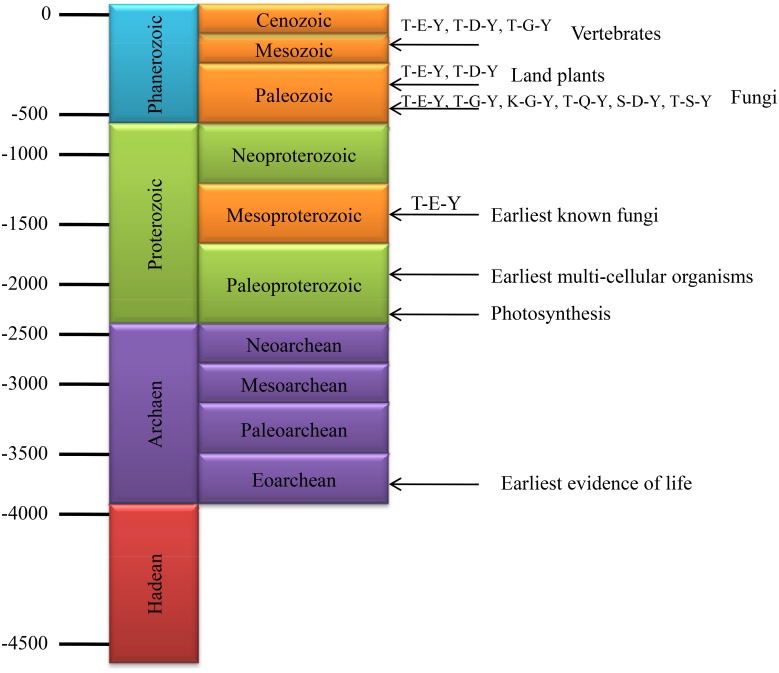
The evolution of mitogen-activated protein kinases (MAPKs).Evolutionary history suggests that fungi have existed since the past 1500 million years. The MAPK that contains T-E-Y motif in activation loop motif is distributed in the plant, animal and fungi kingdoms. So, it can be speculated that the T-E-Y motif containing MAPKs is the most ancient form MAPK, and existed since the past 1500 million years. Except for the T-E-Y motif, T-G-Y, K-G-Y, T-Q-Y, S-D-Y and T-S-Y motifs containing MAPKs have evolved around 4.5 million years ago. The T-D-Y motif containing MAPK is absent in fungi and only present in plants and animals. This suggests that the T-D-Y motif containing MAPKs evolved around four million years ago. All the time scales are based on millions of years.